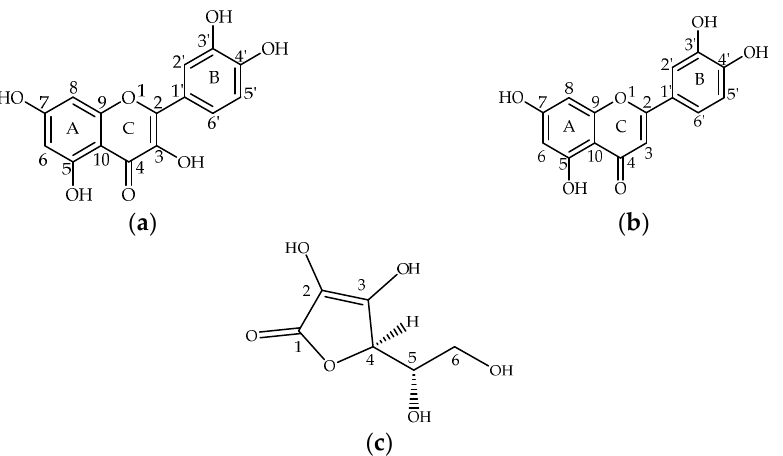
Figure 1. Chemical structure of the investigated natural antioxidants: quercetin ( a ), luteolin ( b ) and L -ascorbic acid ( c ).